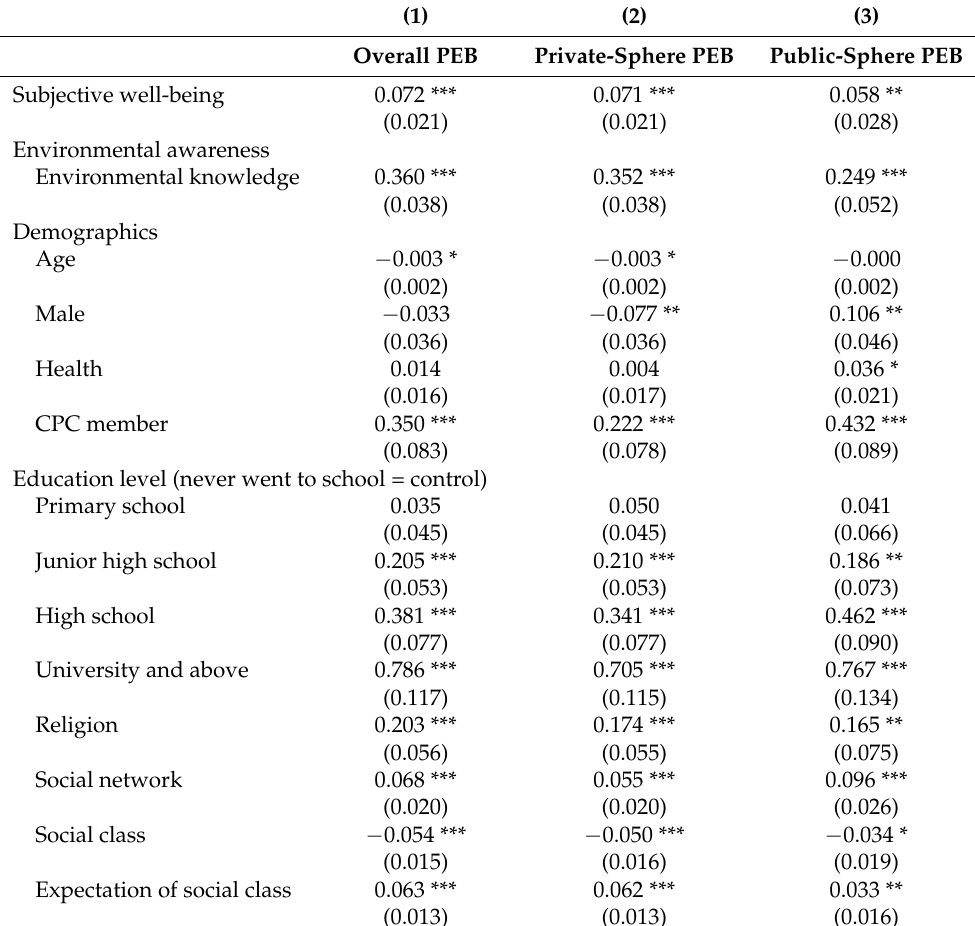
Table 2. The influence of subject well-being on the PEB of rural